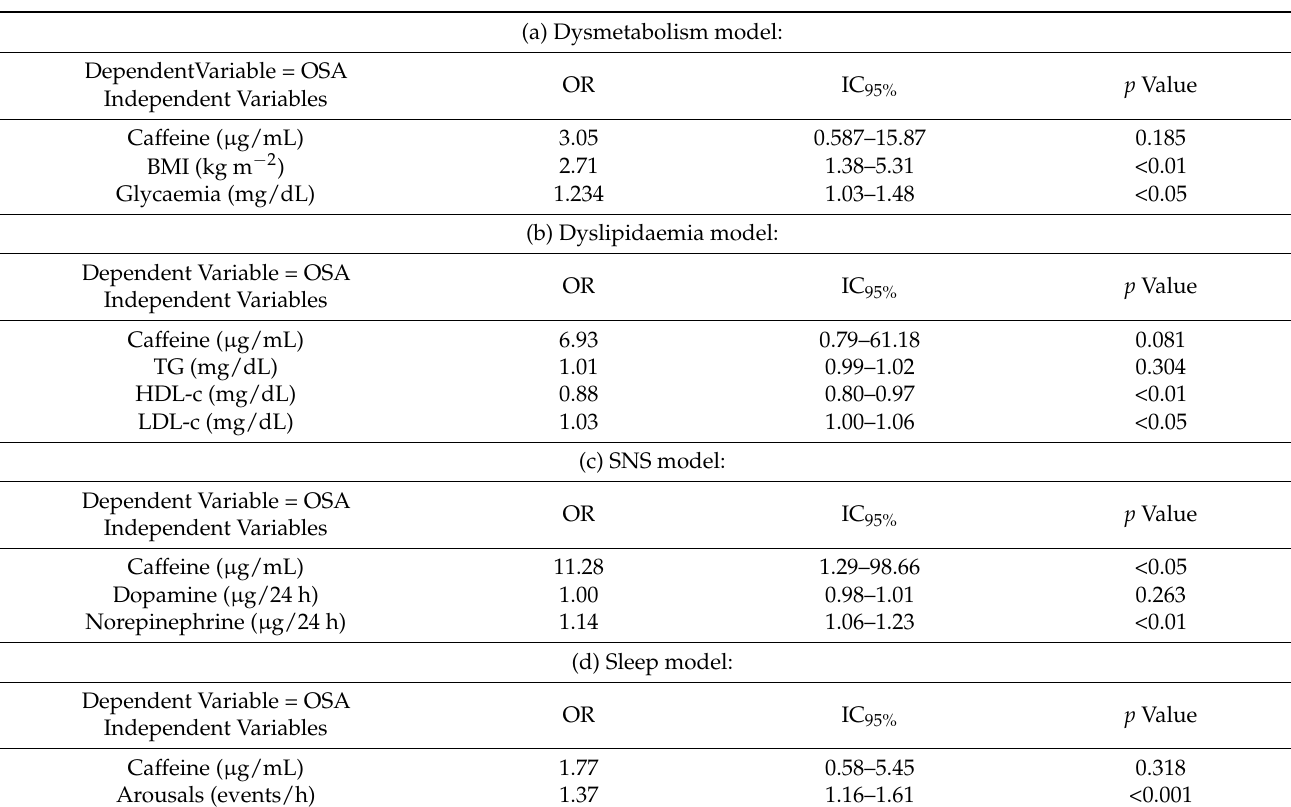
Table 5. Multivariate logistic regression for four different models with OSA as dependent variable and testing the effect of caffeine on variables association with the development of the pathology. Variables for testing caffeine effect on the association of OSA with: (a) dysmetabolism-related